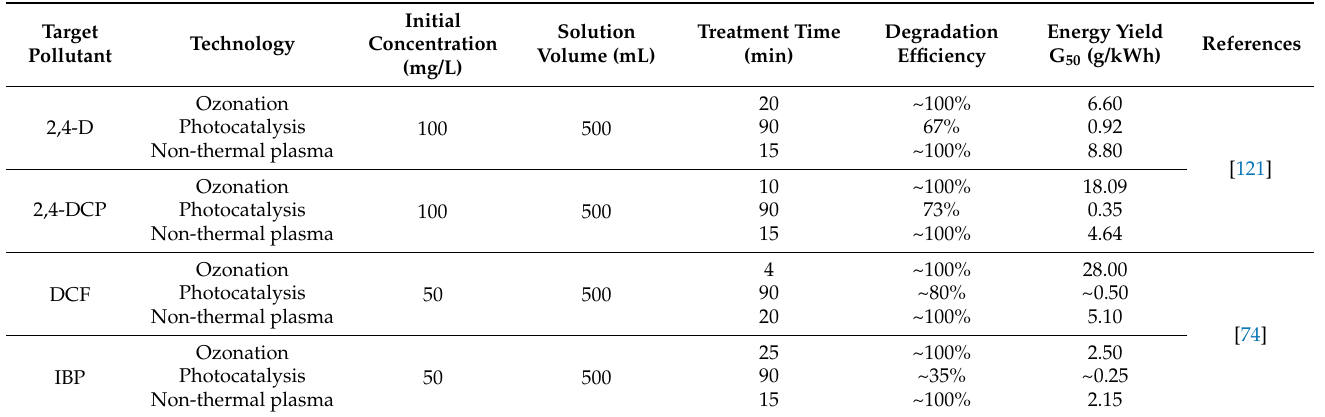
Table 3. Comparison of EOPs degradation by non-thermal plasma and other